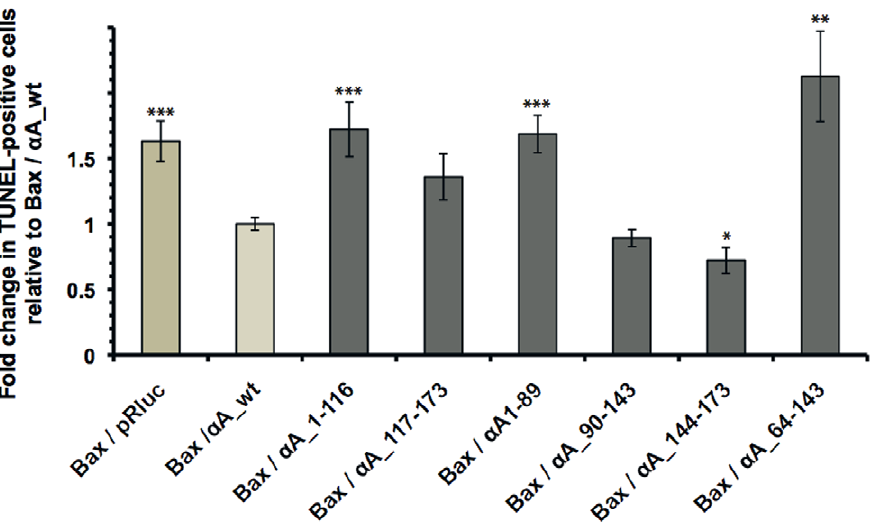
Figure 8. The C-terminal extension domain of a A-crystallin was sufficient to provide protection against Bax-induced apoptosis. Twenty-four hours post-transfection, 293T cells transfected with Bax (Bax/pRluc) or with Bax and a A-crystallin wt or mutants were assayed in TUNEL assay. Counting of TUNEL-positive apoptotic cells showed that a A_wt (Bax/ a A_wt), a A_90-143 (Bax/ a A_90-143) and a A_144-173 (Bax/ a A_144-173) significantly inhibited Bax-induced apoptosis, whereas N-terminal a A_1-89 (Bax/ a A_1-89) and a A_1-116 (Bax/ a A_1-116), along with a A_64-143 (Bax/ a A_64-143) containing the a -crystallin domain, did not prevent apoptosis. (* p , 0.05, ** p , 0.01, *** p , 0.005 by t -test versus Bax/ a A_wt). Data are the mean 6 SE of two to three independent experiments.